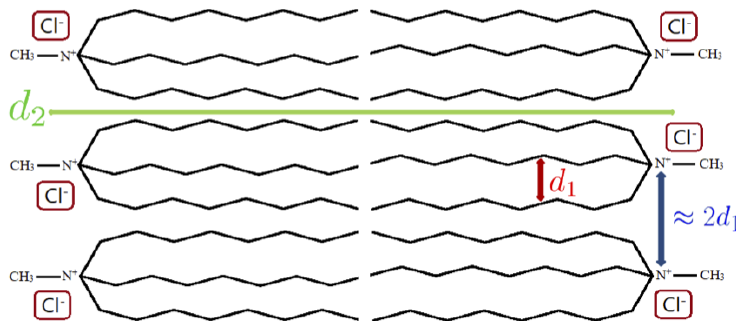
Figure 3. Schematic representation of the bi-layered disposition of the [Aliquat][Cl] ionic liquid. The distances d 1 and d 2 are relate to the X-ray characteristic distances presented in Table 2. In addition, the distance between polar areas of the [Aliquat] + ions is illustrated, which is approximately 2 d 1